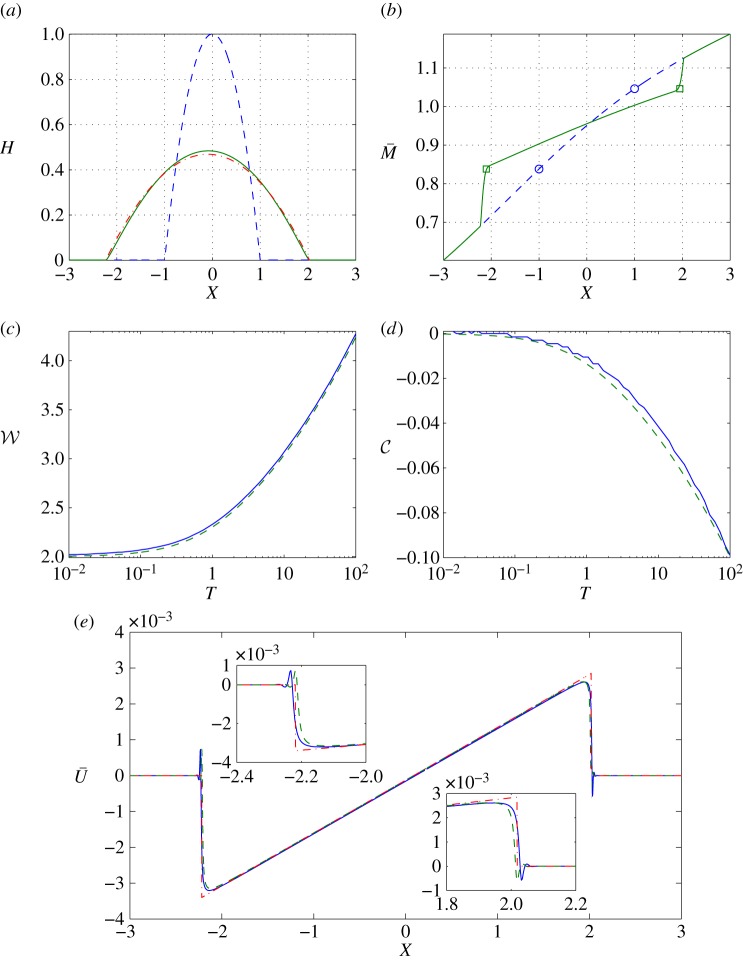
A realization of (2.1) with σ=0.5, l=5, Pe=105 and η=10−3, and its asymptotic approximation. (a) H at T=0 (dashed) and T=100 (solid) calculated from (2.1) and H at T=100 from leading-order outer asymptotic solution (4.4) (dashed-dotted); (b) M¯ at T=0 (dashed) and T=100 (solid) calculated from (2.1), where circles show initial values of M at X=−1 and X=1, that is M+=1.046 and M−=0.8382, and squares show the position of M± at T=100 convected by U¯; (c) drop width W calculated from (2.1) (solid) and from the low-order model (4.25), (4.28) (dashed); (d) drop centre C calculated from (2.1) (solid) and from (4.25) and (4.28) (dashed); (e) bulk velocity U¯ (solid) and its asymptotic approximations U¯out (4.8) (dashed) and U¯com (4.31) (dotted-dashed), at T=100, with insets showing close-ups near each contact line. (Online version in colour.)